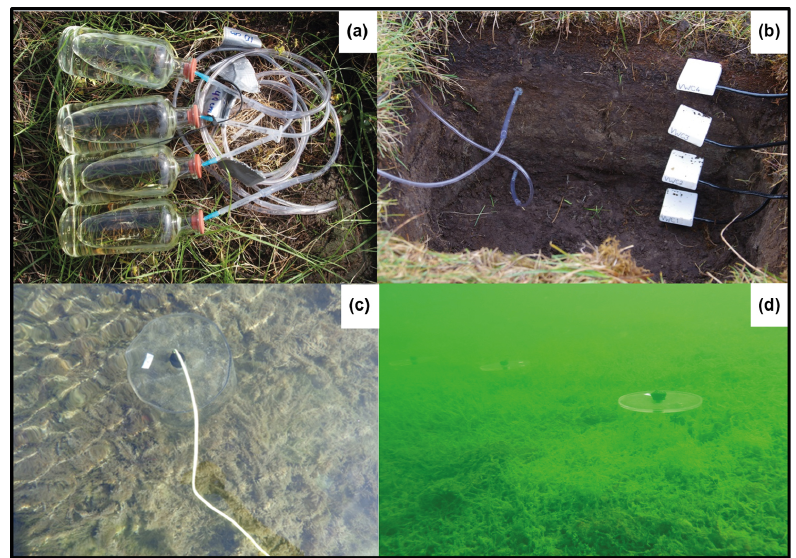
Figure 5. Photos of lysimeter flasks (a) , lysimeter installation (left in the pit) (b) and respiration chambers for benthic production/respiration measurements (c, d) .